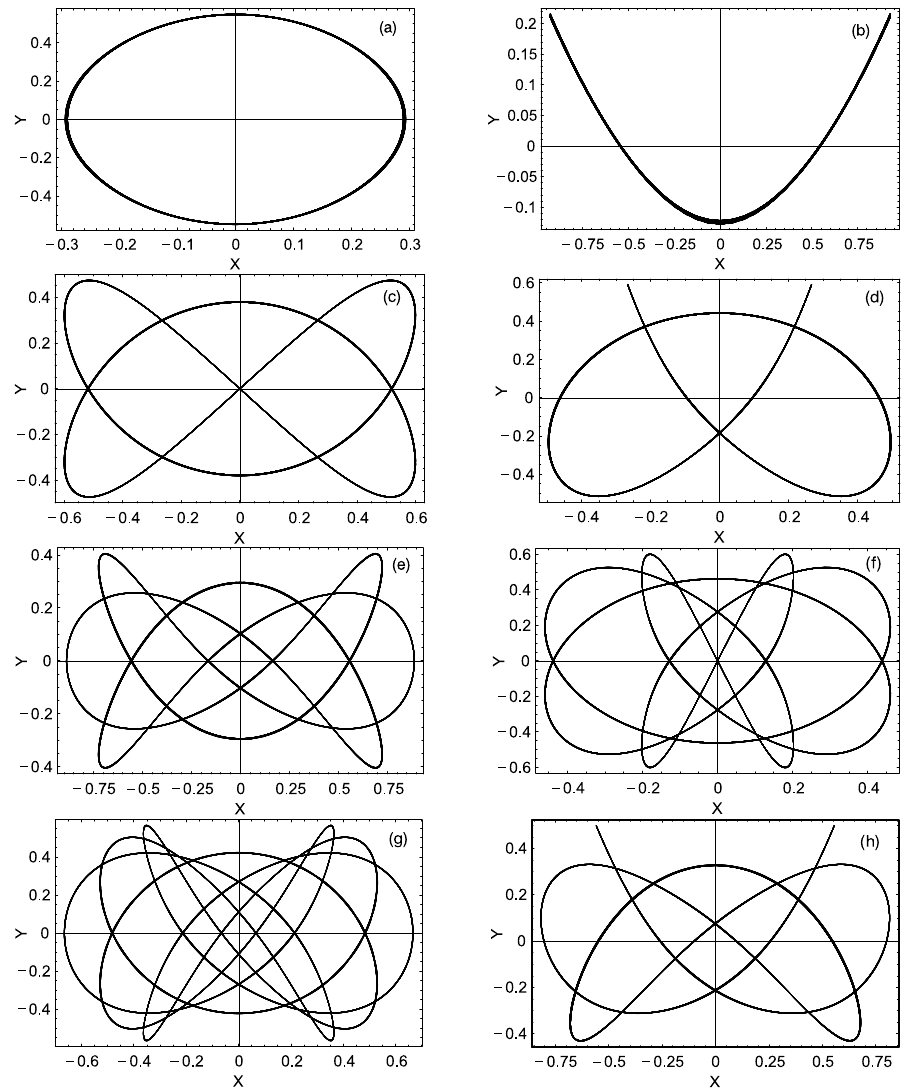
Fig. 6. Panels (a)–(h): representative periodic orbits in the 2D dynamical system. The initial conditions are (a): x 0 = 0 : 2943, p x 0 = 0; (b): x 0 = 0 : 548, p x 0 = 10 : 8; (c): x 0 = 0, p x 0 = 13 : 07; (d): x 0 = 0 : 097, p x 0 = 7 : 7; (e): x 0 = 0 : 889, p x 0 = 0; (f): x 0 = 0, p x 0 = 4 : 675; (g): x 0 = 0 : 667, p x 0 = 0 and (h): x 0 = 0 : 803, p x 0 = 2 : 03.